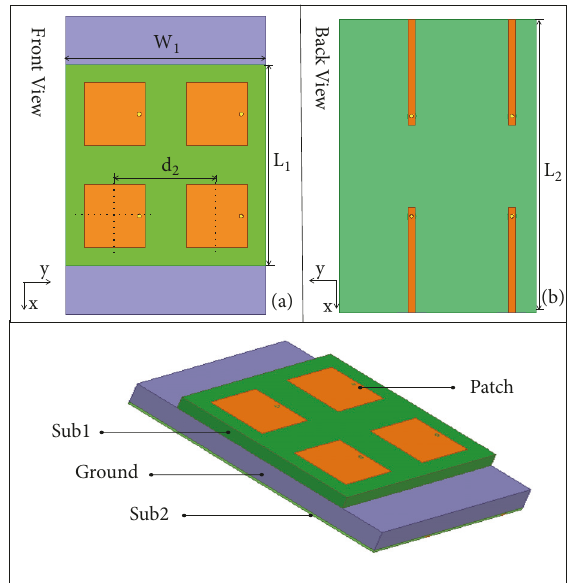
Figure 2: The configuration of the generator.